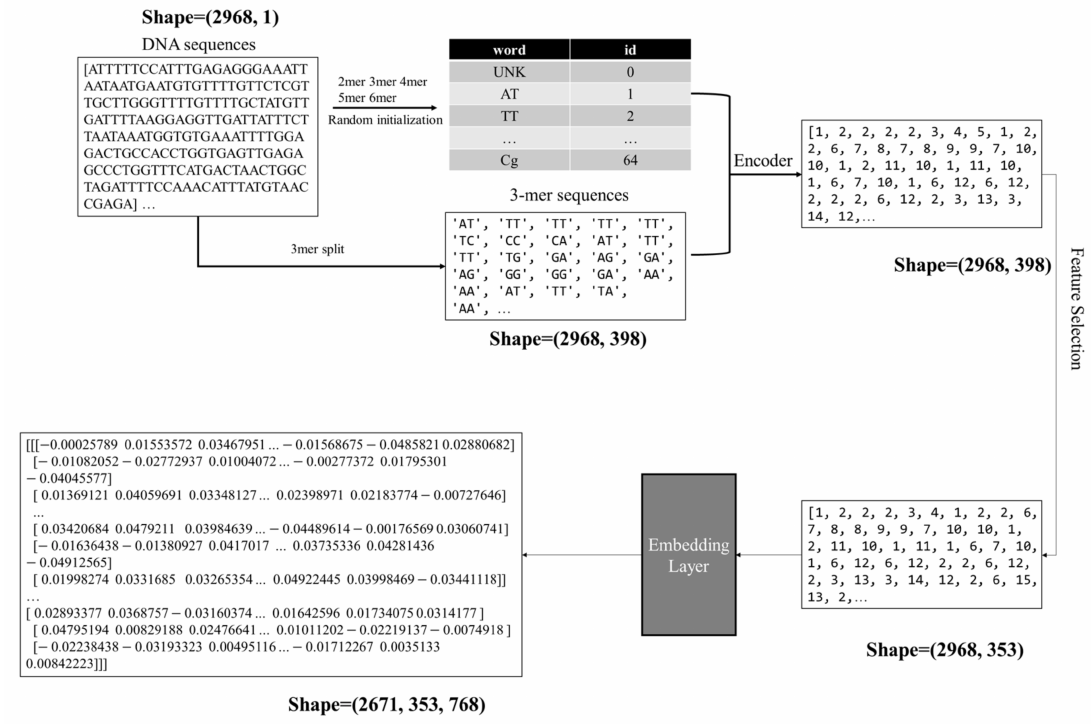
Figure 4. Illustration of the nucleotide sequence vectorization